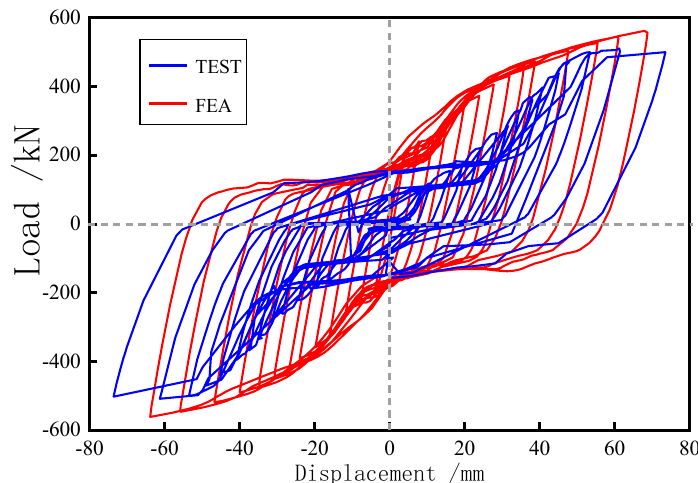
Figure 16. Comparison of hysteretic curves between test and finite element analysis of RSL-7.